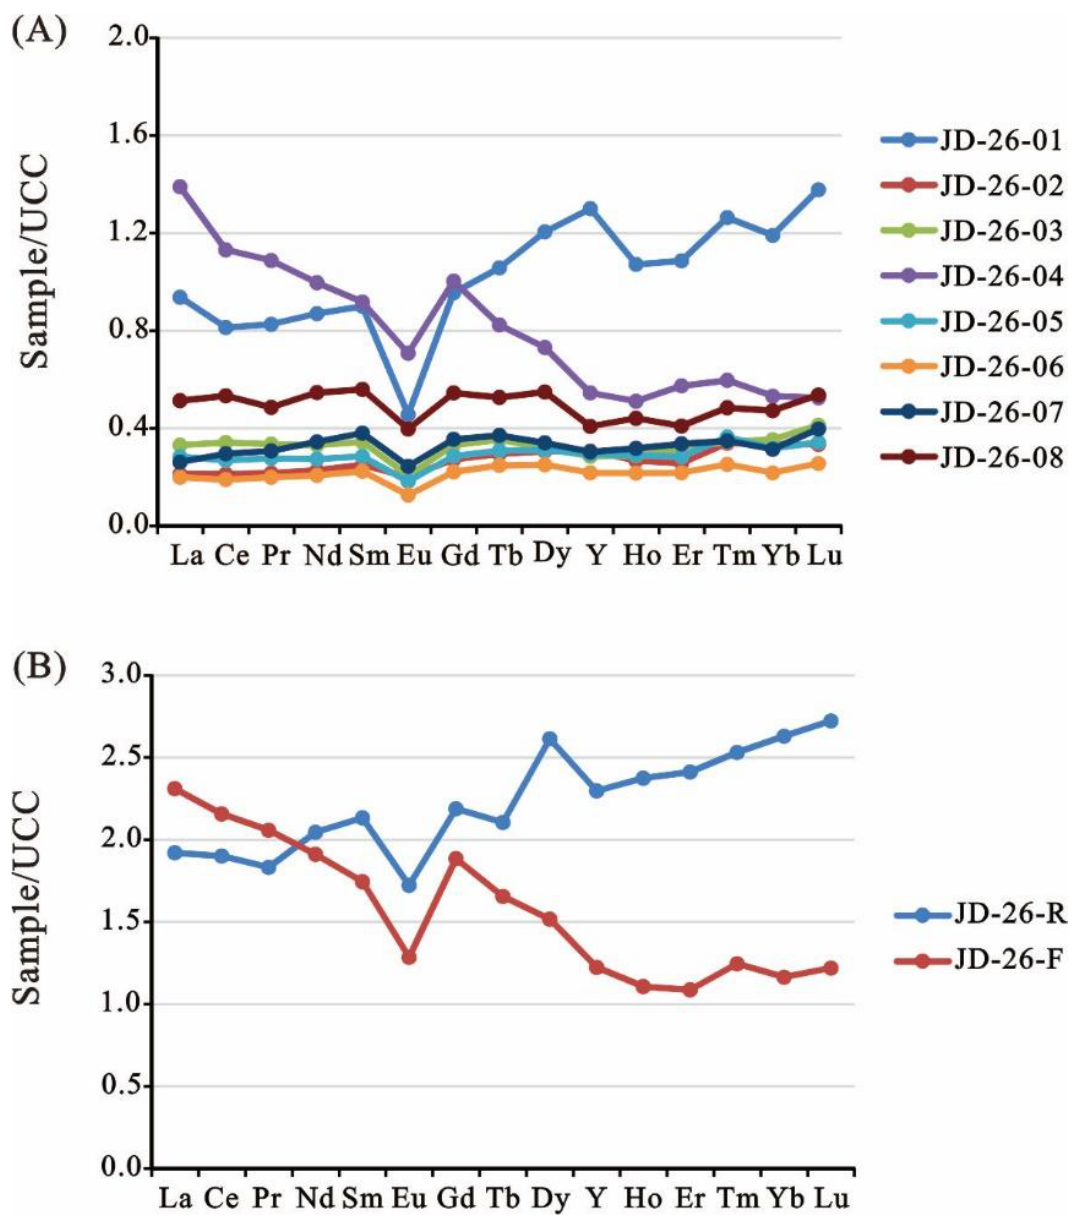
Figure 8. REY characteristics for ( A ) coal samples, ( B ) roof and floor samples in Junde mine. REY contents were normalized by UCC.